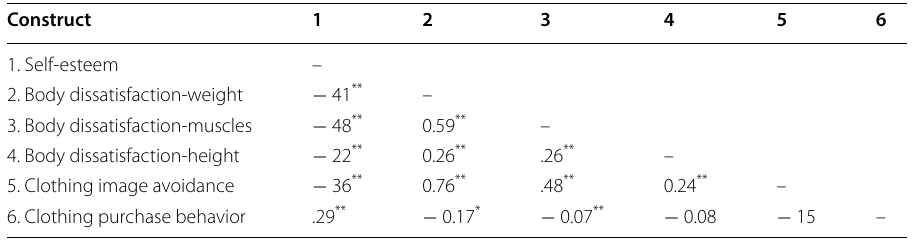
Table 2 Correlation analyses